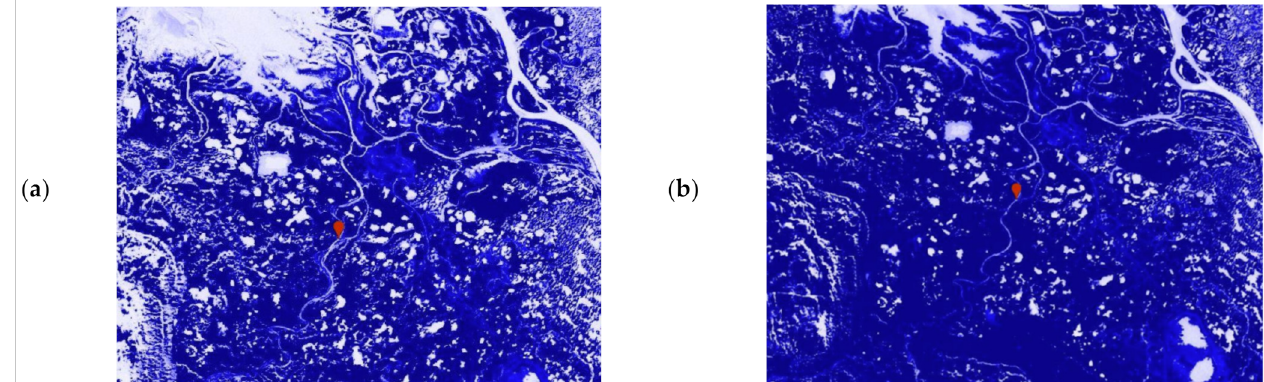
Figure 12. NDSII Results ( a ) for the image taken 14 May 2020, ( b ) for the image taken 13 June